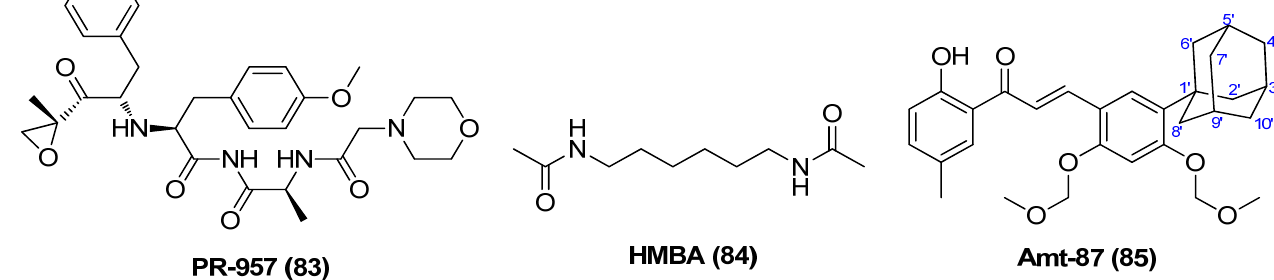
Figure 16. Chemical structures of P-TEFb activators (83~85) with HIV-1 reactivation